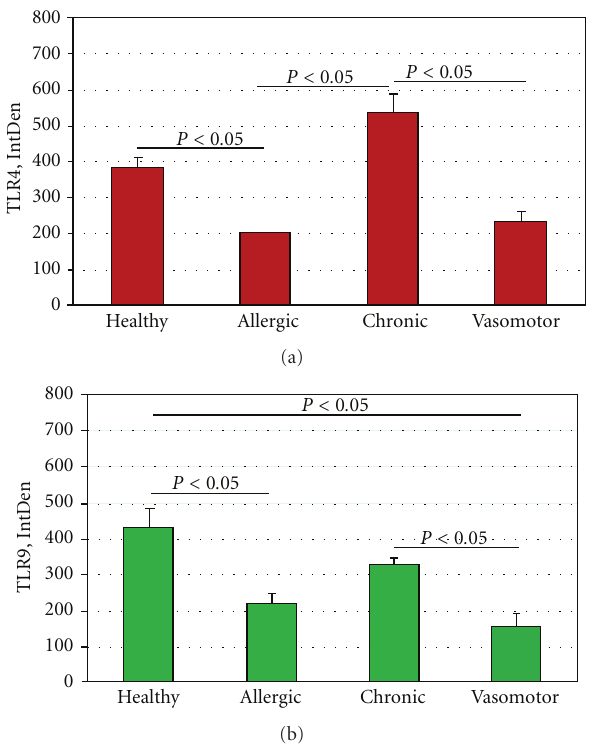
Figure 5: ANOVA analysis of IntDen values among di ff erent